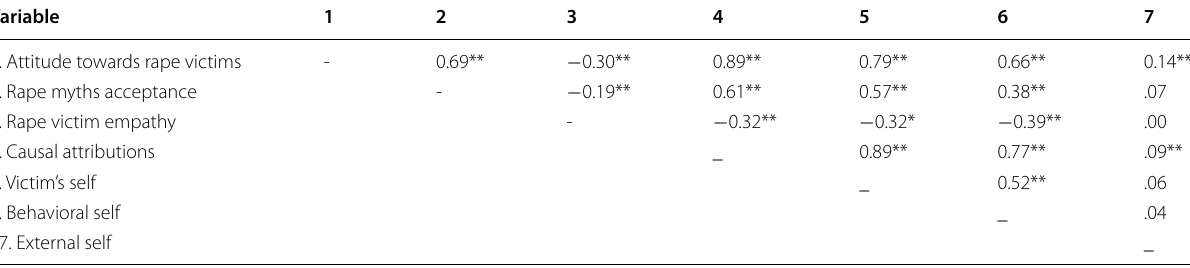
Table 3 Intercorrelations for attitudes towards rape, rape victims empathy, rape myths acceptance, and causal attributions and its subscales